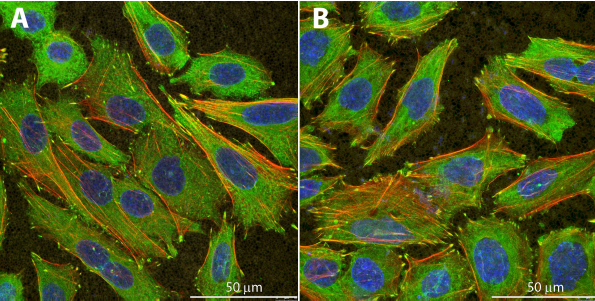
Figure 3. Immunofluorescence staining of vinculin, a protein of focal adhesion plaques (green) in human osteoblast- like Saos-2 cells on day 3 after seeding on SC-Si(100) (A) or SC-SS (B). The actin cytoskeleton is stained in red with phalloidin-TRITC, and the cell nuclei are stained in blue with DAPI. Leica TCS SPE DH 2500 confocal microscope.